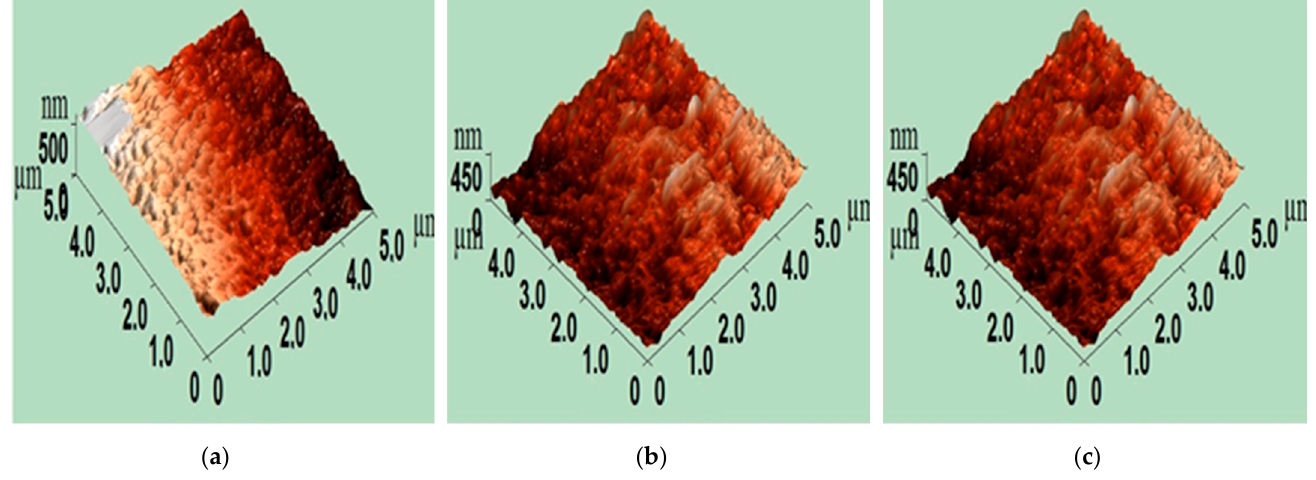
Figure 4. 3-D surface models of phosphate coatings: ( a ) From a modified solution; ( b ) From a solution with the addition of zinc nitrate; ( c ) From a solution with the addition of calcium nitrate.